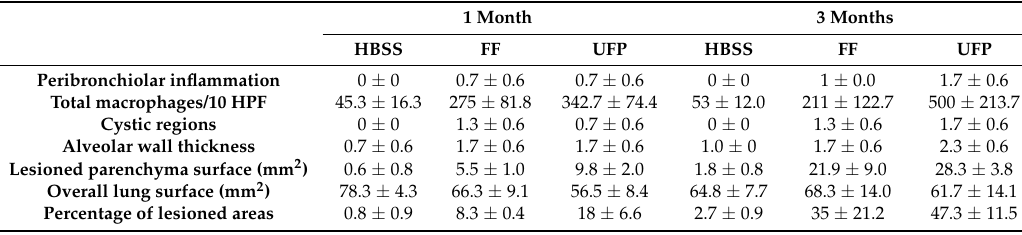
Table 4. Summary of histological lung changes following sub-chronic exposure to particles. 1 Month 3